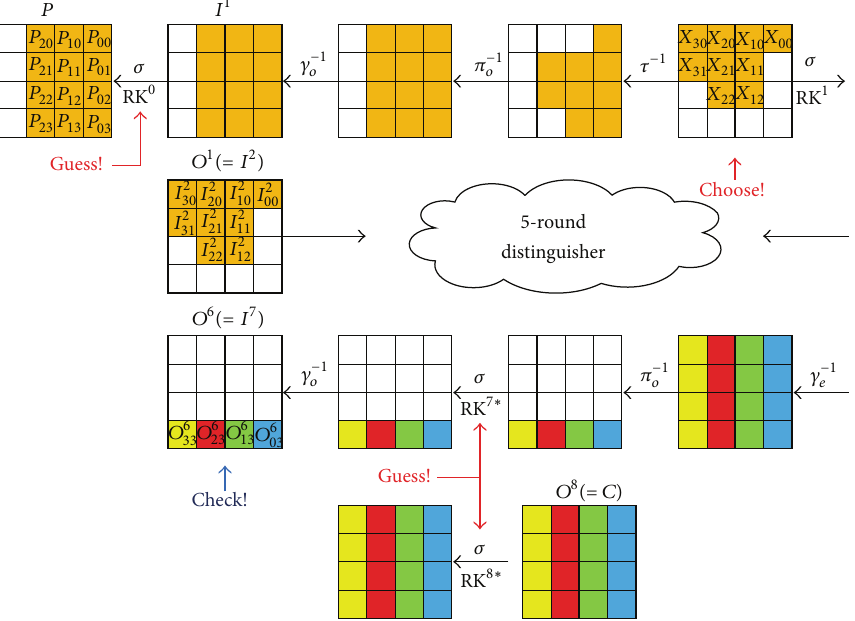
Figure 5: The attack procedure on Crypton-192/256 and mCrypton-96/128.